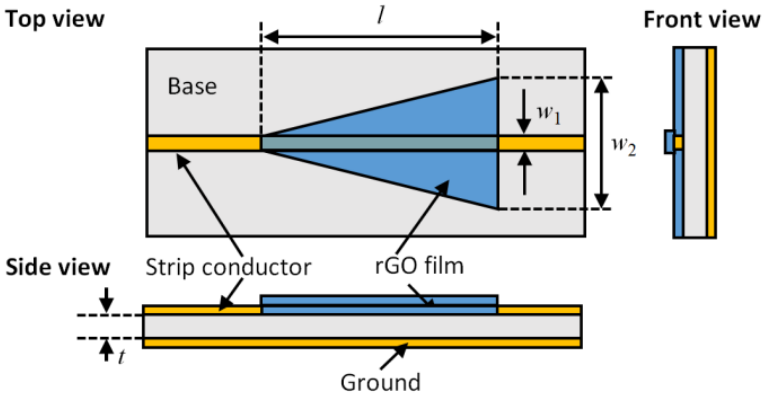
Figure 1. Illustration diagrams of the laser-scribed termination.